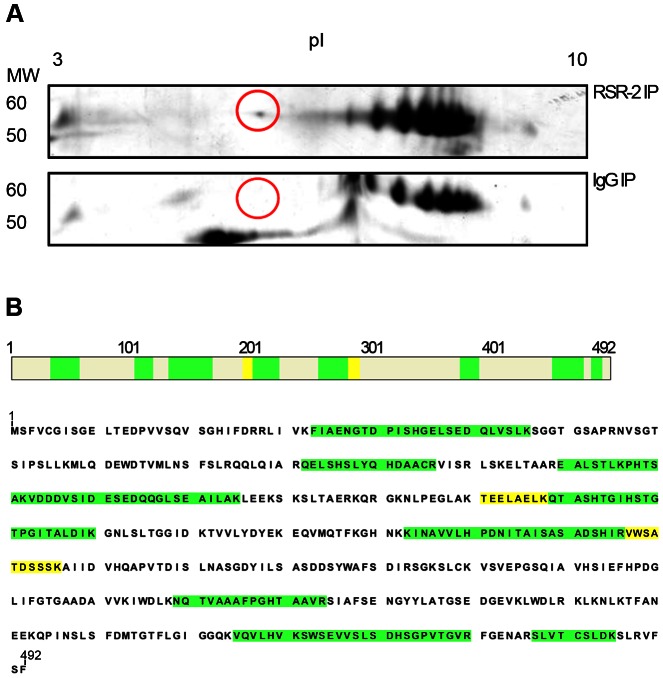
RSR-2 interacts with PRP-19.(A) After immunopurifying protein complexes from C. elegans mixed staged populations with a rabbit RSR-2 specific antibody and an unspecific rabbit antibody against IgG, both protein samples were run in bidimensional gels. Gels were silver-stained and the spot of interest was manually excised for further LC-MS/MS analysis. Proteins were separated in the bidimensional gel by molecular weight (MW) and isoelectric point (pI). The selected differential spot is circled in red. (B) This spot corresponds to the pre-mRNA processing factor PRP-19. 13 unique peptides with a PSM (Peptide Spectral Match) of 22 match the PRP-19 sequence. High confidence identity peptides are represented in green (q<0.01) and medium confidence identity peptides are represented in yellow (q<0.05).